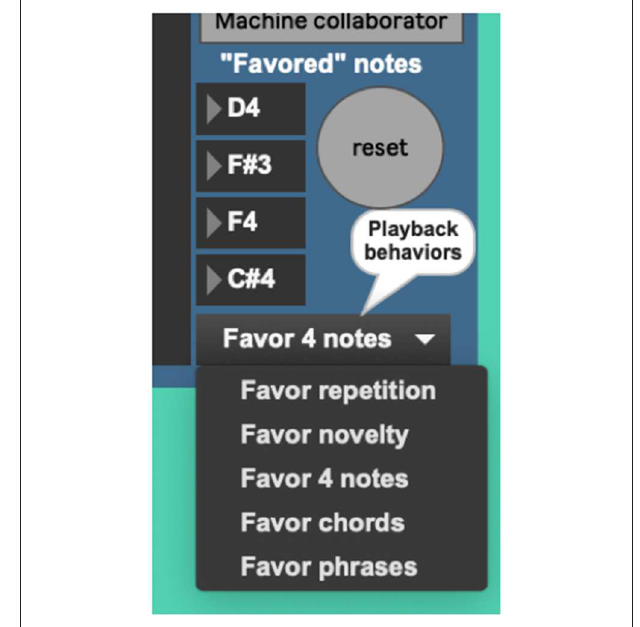
FIGURE 11 | AvatarPlayer’s various playback